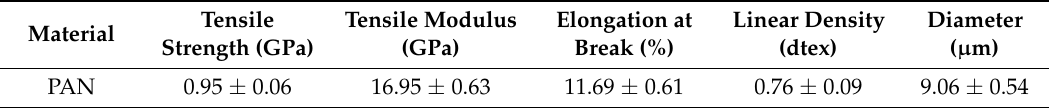
Table 1. Properties of PAN precursor fibres.